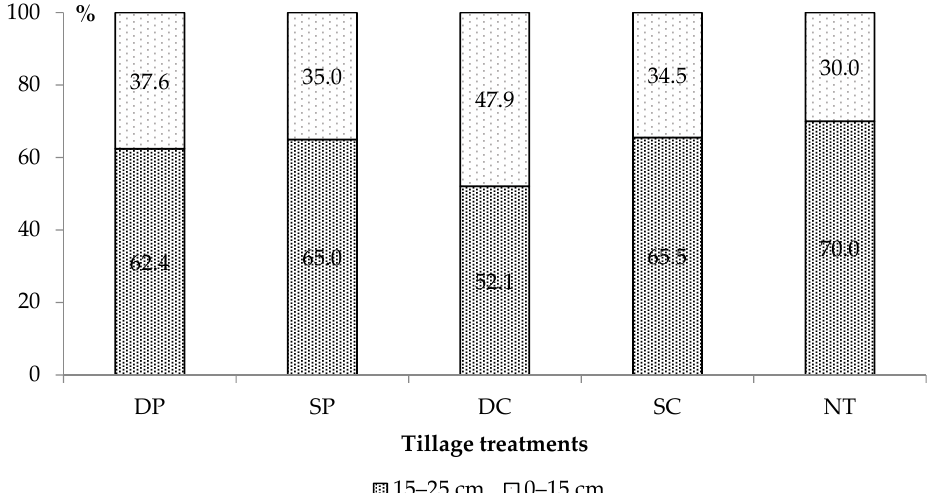
Figure 3. Weed seedbank distribution between soil layers. DP–deep plowing (control treatment), SP–shallow plowing, DC–deep cultivation, SC–shallow cultivation, NT–no-tillage (direct drilling). p > 0.05.